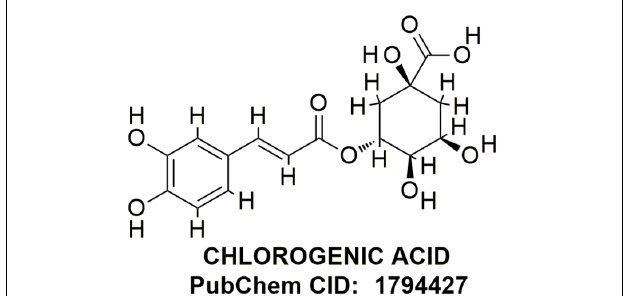
FIGURE 1 | Chemical structure of chlorogenic